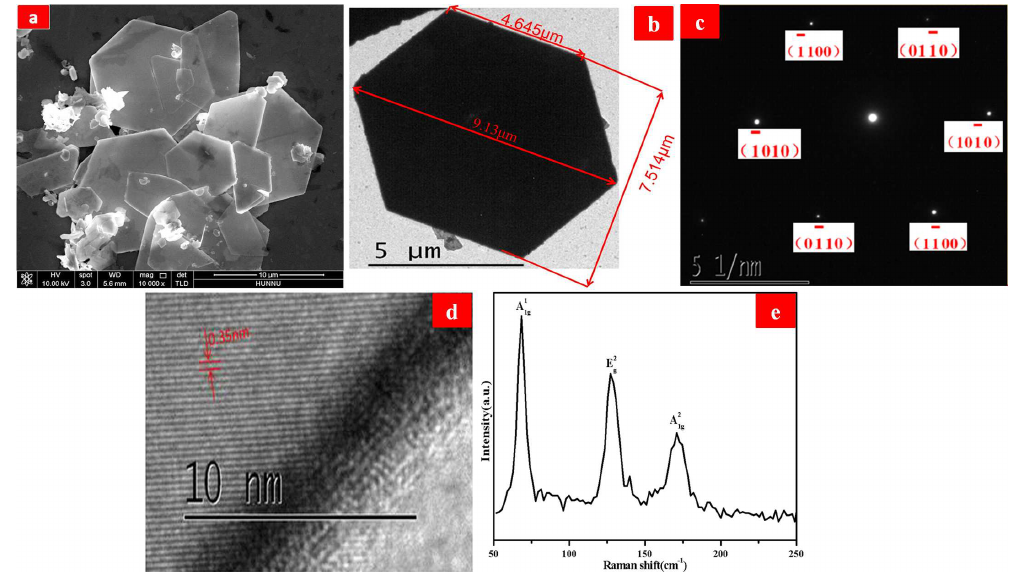
Figure 2. ( a ) SEM image. ( b ) Low magnification TEM image. ( c ) SAED pattern. ( d ) HRTEM image. ( e ) Raman spectrum at room temperature of single Bi 2 Se 3